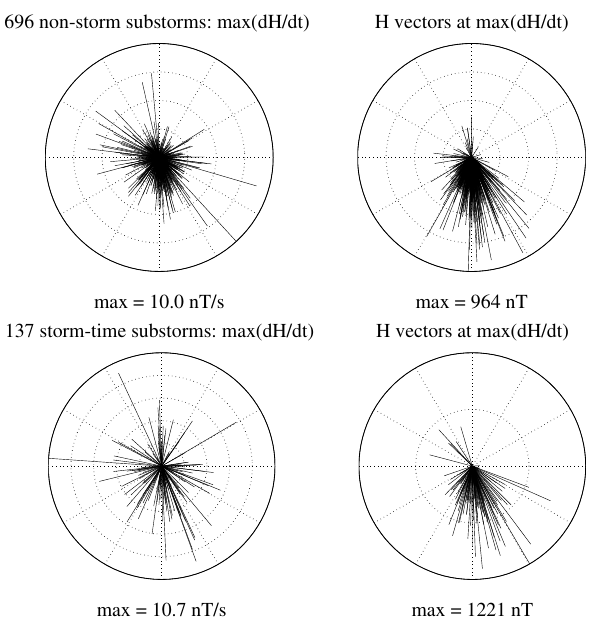
Fig. 8. Upper row: max( d H /dt ) vectors of non-storm substorms, and simultaneous H vectors at the maximum sites of d H /dt . Lower row: the same for storm-time substorms. The north direction is up and the east direction to the right.